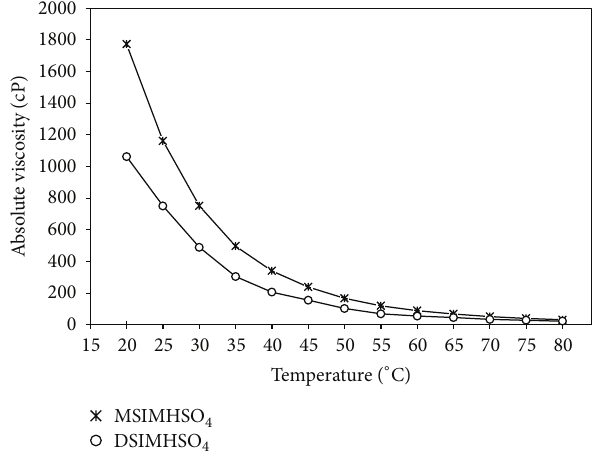
Figure 7: Effect of temperature on absolute viscosity of DSIMHSO 4 and MSIMHSO 4